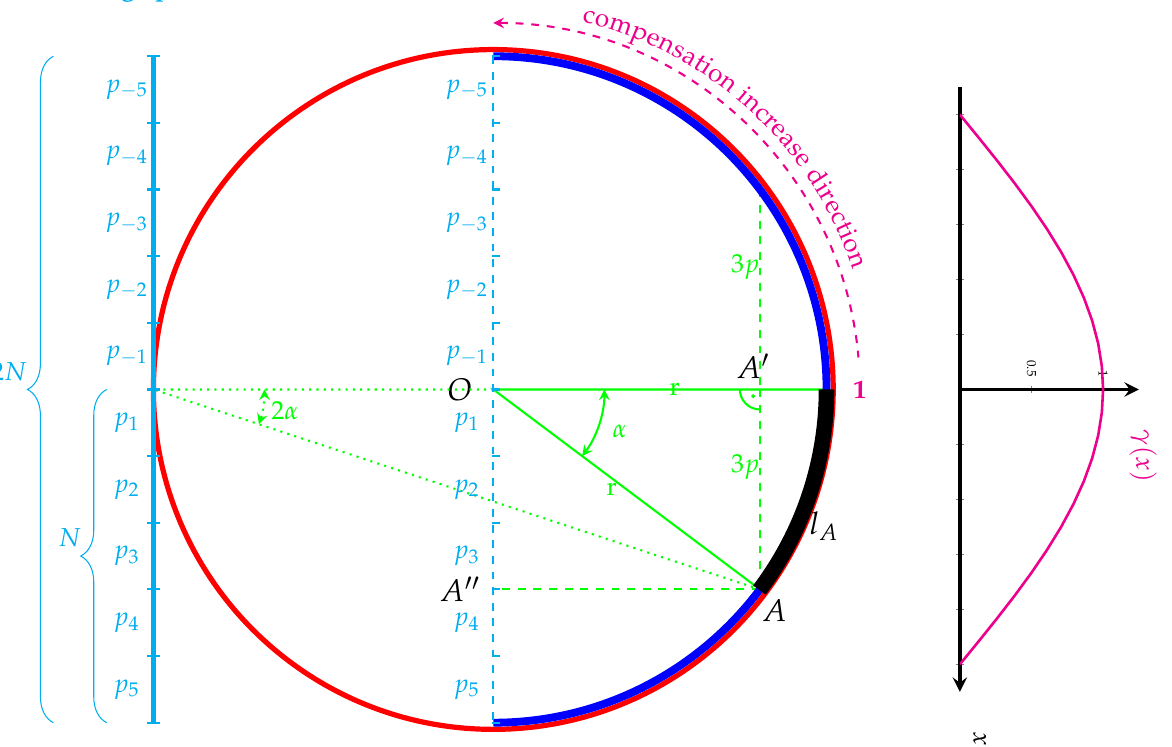
Figure 1. The principle for luminance weights determination in 2D space projected onto 1D. Based on the observation that in UWFA images, the brightness and contrast fade with the distance from the center, the centrally located pixel does not require brightness correction. Thus, it is processed without changes (i.e., the correction coefficient is 1). Other pixels that express retina points situated farther away from the center require revision that depends on pixel location (represented by the distance from the center). The farther away the pixel from the center is, the more substantial pixel value correction is required. A direction of increasing demand for correction is presented in Figure 1 using a magenta curved arrow.